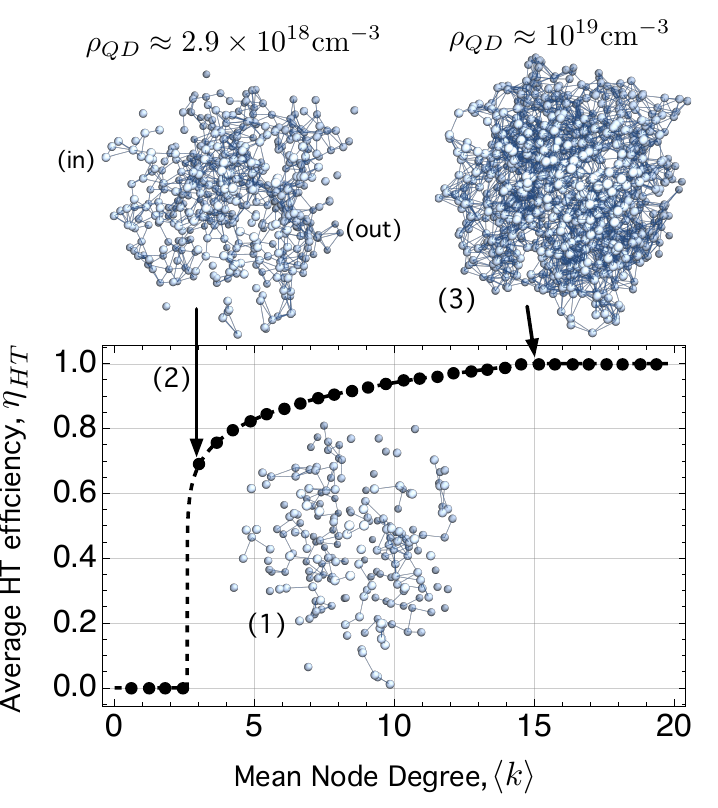
Figure 4. η , average value of the electron hopping transport efficiency, η HT , computed using HT Equation (32), as a function of the mean node degree ⟨ k ⟩ . Each dot on the curve corresponds to the mean value obtained over 50 realizations of the network. Inset (1) shows a disconnected network with small isolated groups of dots. Inset (2) is a percolation sub-network connecting two opposite points in the sample, labeled “in” and “out”. Inset (3) represents a connected network in which all the nodes are linked to at least one other, allowing any carrier to hop across the network a distance on the order of the hole diffusion length, L h